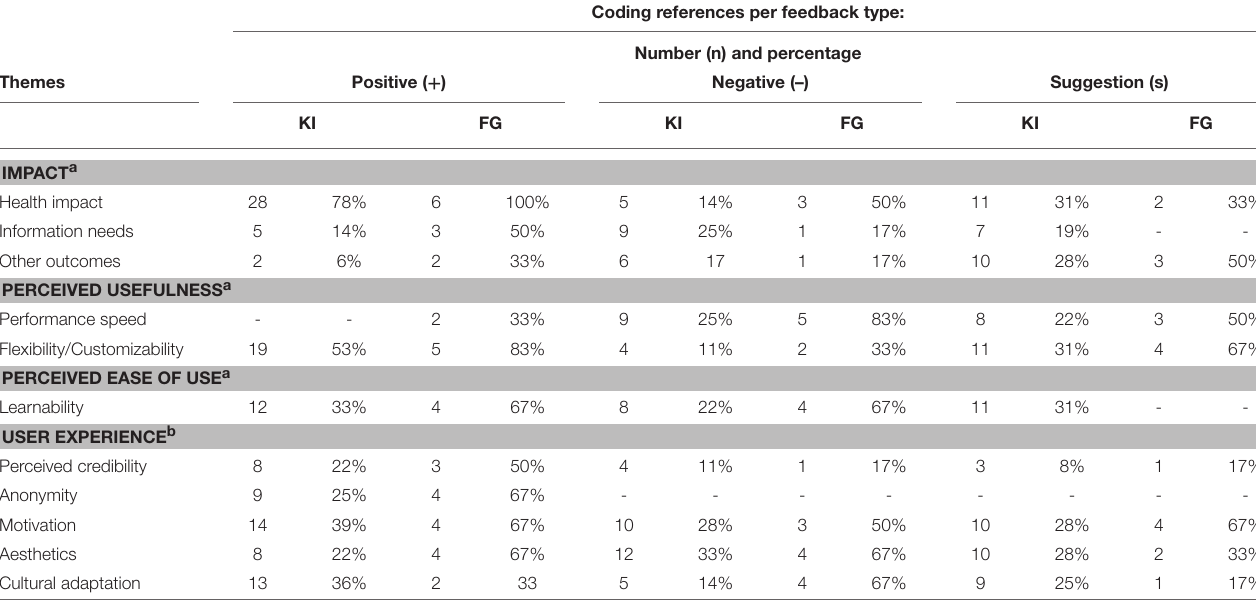
Coding references per feedback